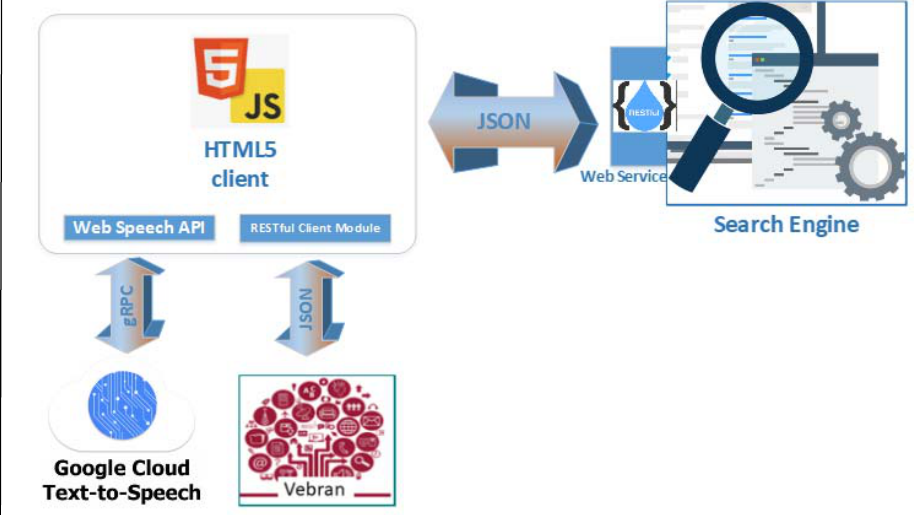
Figure 1 – Frontend – Backend communication with speech recognition Рис . 1 – Взаимодействие пользовательской и серверной частей